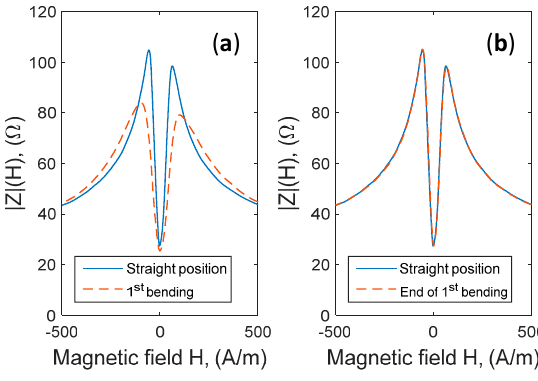
Figure 6. Cont. Figure 6.